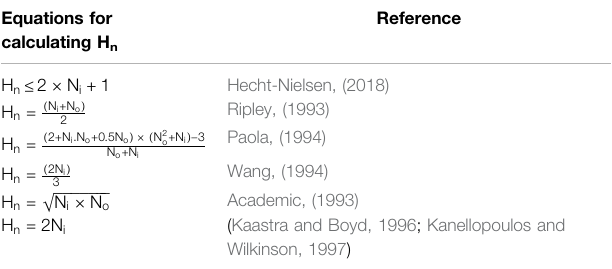
TABLE 7 | Equations from the literature for the determination of H n . Equations for calculating H n